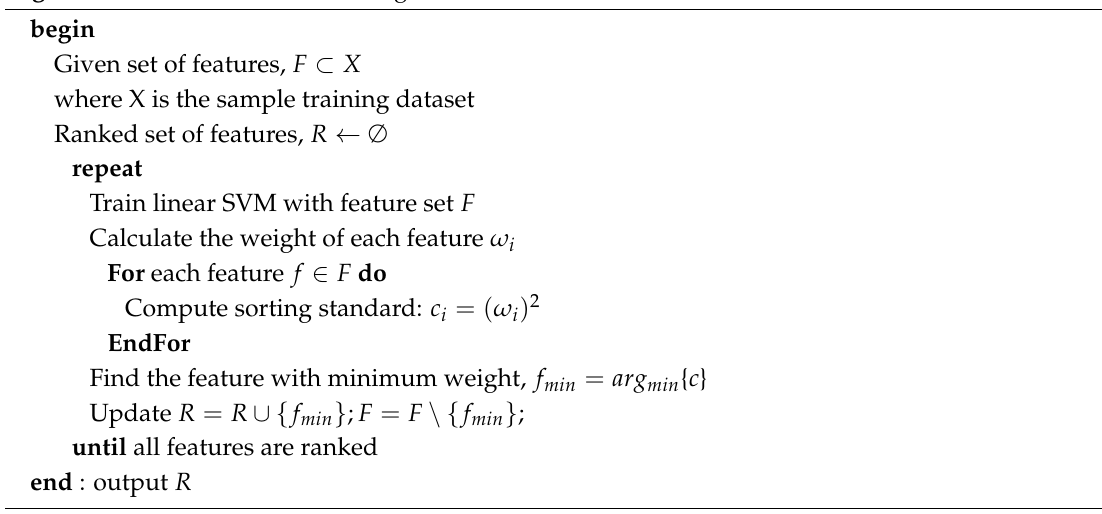
Algorithm 1 : SVM-RFE for Ranking